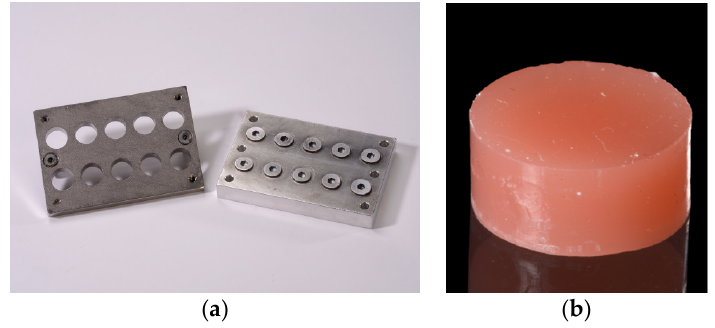
Figure 4. ( a ) Casting mold for PMMA cylinders and ( b ) PMMA cylinder after polymerization. Both PMMA cylinders and cubes were divided into four test series with five specimens each. Within the cubes the intaglio U-profile surfaces were coated with chitosan, whereas on the cylinders chitosan coatings were carried out on the frontal surfaces that were cured against the glass